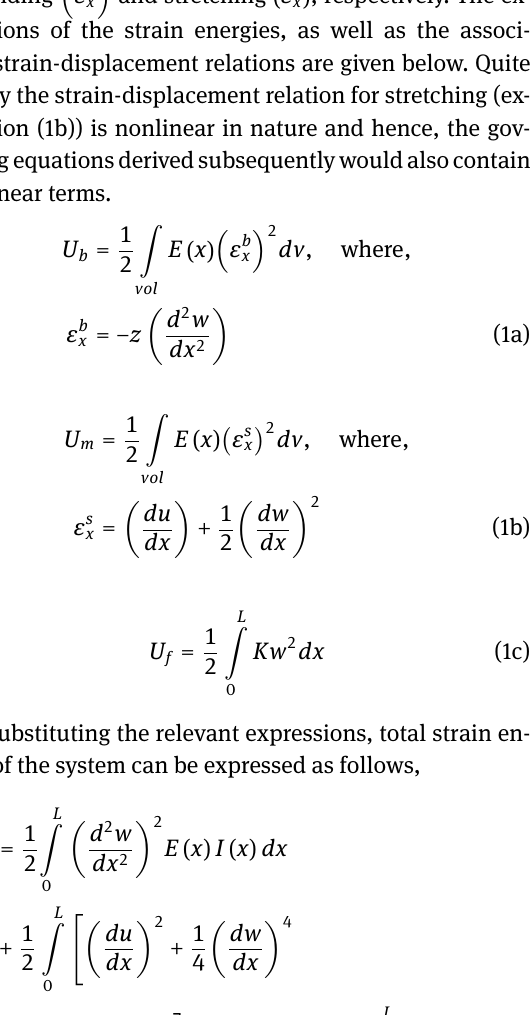
Figure 1: (a) Schematic representation of an AFG beam on Elastic Foundation, (b) Idealization of elastic foundation by a series of linear